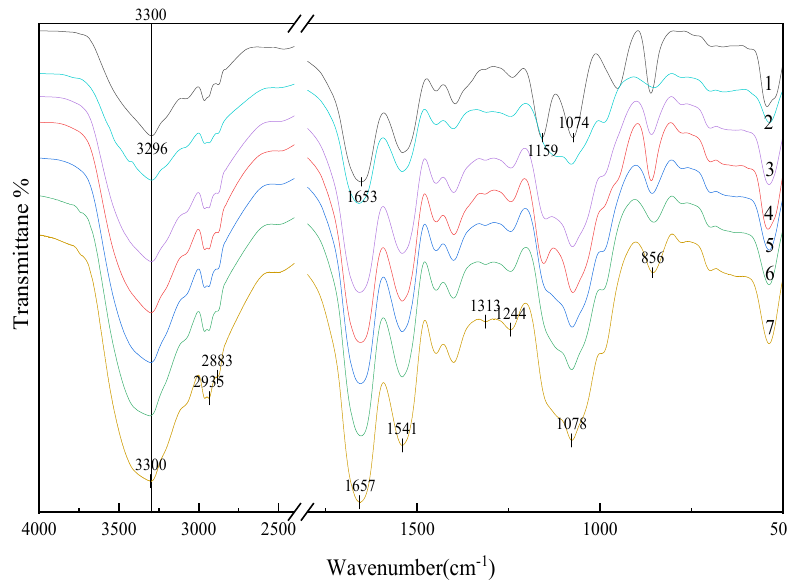
Figure 7. FT-IR spectra of the samples. 1 is the native soy protein isolate; 2 represents the mixture of SPI and GOS; 3 represents the traditional wet heating Maillard reaction group; 4–7 represent the 80 MPa, 100 MPa, 120 MPa, 140 MPa HPH treatment groups, respectively.